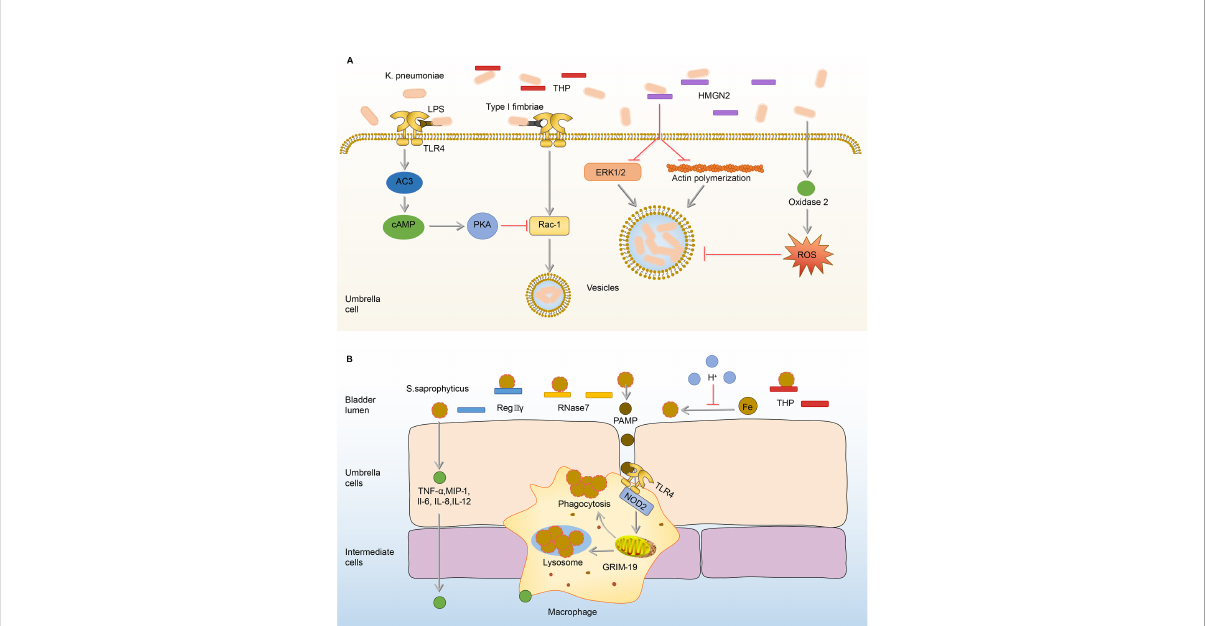
FIGURE 4 Immune responses to K. pneumoniae and S.saprophyticus in the bladder. (A) In the urine, THP exerts anti-adhesion and anti-in fl ammation effects on K. pneumoniae . Once adhered, K. pneumoniae lipopolysaccharide activates TLR4 to initiate AC-3/cAMP/PKA signaling pathway, then down-regulates Rac-1 and abrogates the endocytic lipid raft. HMGN2 also can inhibit K. pneumoniae internalization by inhibiting the attachment of bacteria and reducing bacterial-induced ERK1/2 activation and actin polymerization. In addition, the ROS promoted by oxidase 2 can inhibit endocytosis. (B) Before adhesion, RegIII g , RNase 7, and THP have anti-adhesion and sterilization abilities to S. saprophyticus . The acidic urine environment suppresses S. saprophyticu uptake and utilization of iron thus limiting its growth. After the adhesion, BECs produce TNF- a , MIP-1, IL-1, IL-6, and IL-12 to recruit macrophages. Upon the activation of TLR4 by PAMP, macrophages phagocytize S.saprophyticus depending on genes associated with GRIM-19. AC-3, adenylyl cyclase-3; cAMP, cyclic adenosine monophosphate; ERK1/2, extracellular-regulated kinase 1/2; GRIM-19, genes associated with retinoid-IFN-induced mortality-19; HMGN2, high-mobility group protein N2; IL-1, interleukin-1; INF- g , interferon- g ; K.pneumoniae , Klebsiella pneumoniae ; MIP-1, macrophage in fl ammatory protein-1; PAMP, pathogen-associated molecular pattern; PKA, protein kinase A; RegIII g , regenerating islet-derived 3 g ; RNase 7, ribonuclease 7; ROS, reactive oxygen species; S.saprophyticus , Staphylococcus saprophytes ; THP, Tamm-Horsfall protein; TLR4, toll-like receptor 4; TNF- a , tumor necrosis factor- a